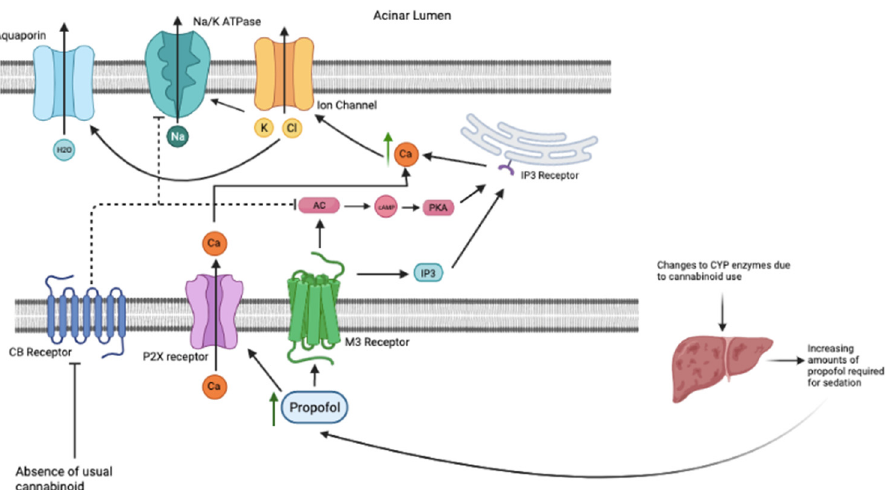
Figure 3. Cannabis Withdrawal and Propofol Administration. The effects of absence of usual can- nabis and administration of Propofol cause a synergistic effect. The cannabis withdrawal removes inhibition on the Adenylate Cyclase (AC) pathway and the Na/K ATPase pump. The increased need for administration of Propofol to ensure sedation due to the CYP enzyme changes from the cannabis use causes an increase activation of the AC and IP3 pathways. Propofol also opens the P2X receptor causes extracellular calcium to move into the cell. The increased intracellular calcium opens the chloride ion channel and allows the release of chloride into the acinar lumen. Sodium and water follow the gradient via their respective channels. Created with BioRender.com (accessed on 1 April 2022).